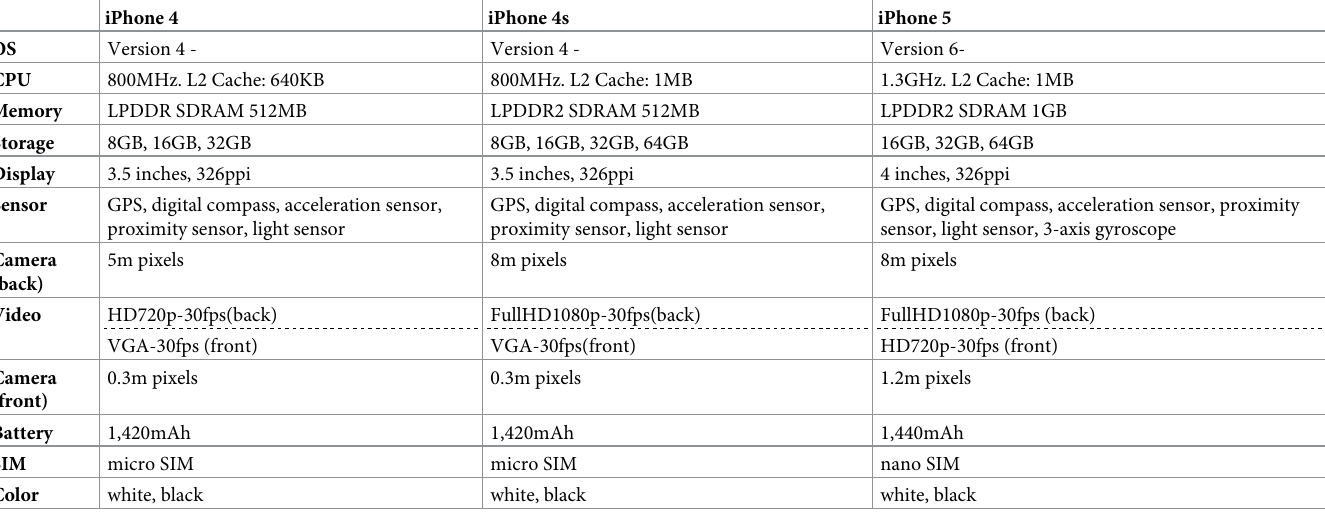
Table 1. Specifications of the 4 th , 4 th -derivative, and 5 th generation iPhone